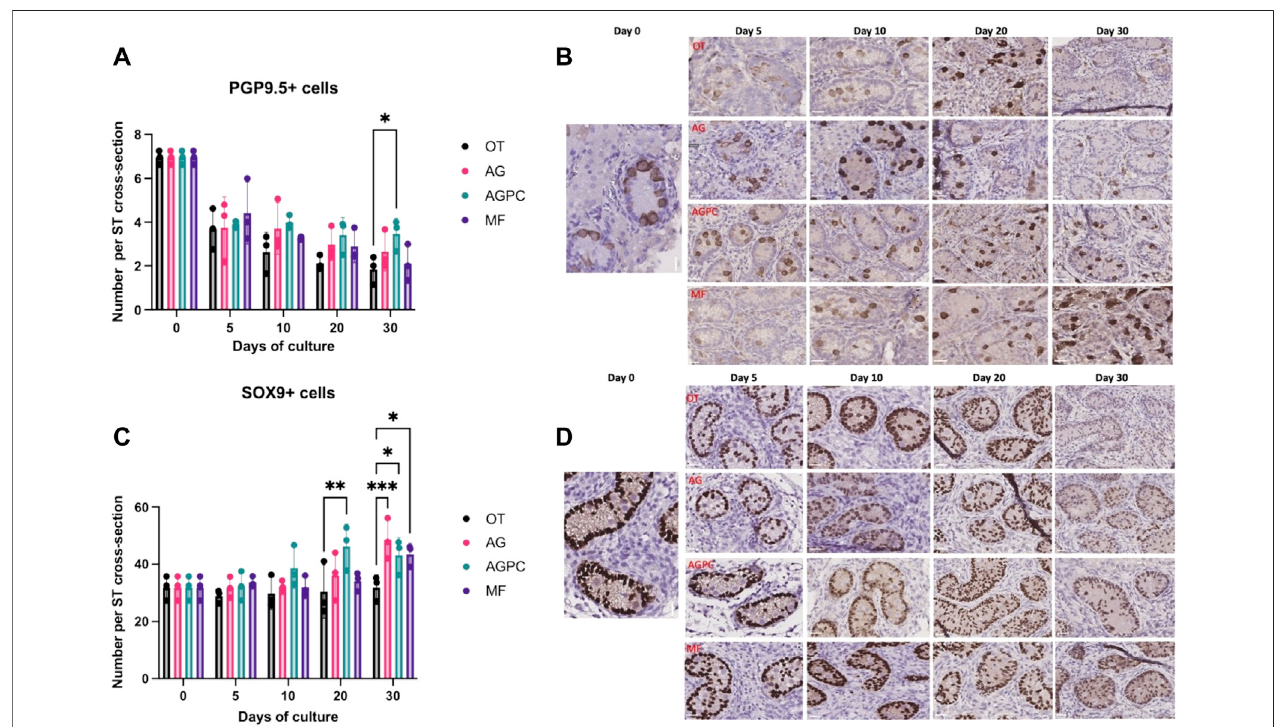
FIGURE 3 | Evolution of undifferentiated spermatogonia and Sertoli cell numbers per ST cross-section over the culture period. (A) : Evolution of the number of PGP9.5 positive cells per ST cross-section over the culture period. (B) : PGP9.5 staining on immunohistochemistry. (C) : Evolution of the number of SOX9 positive cells per ST cross-section over the culture period. (D) : SOX9 staining on immunohistochemistry. OT, culture insert PTFE; AG, Agarose; AGPC, Agarose + PDMS cover; MF, Micro fl uidic. Images shown at ×400 magni fi cation. Scale bars = 20 μ m.